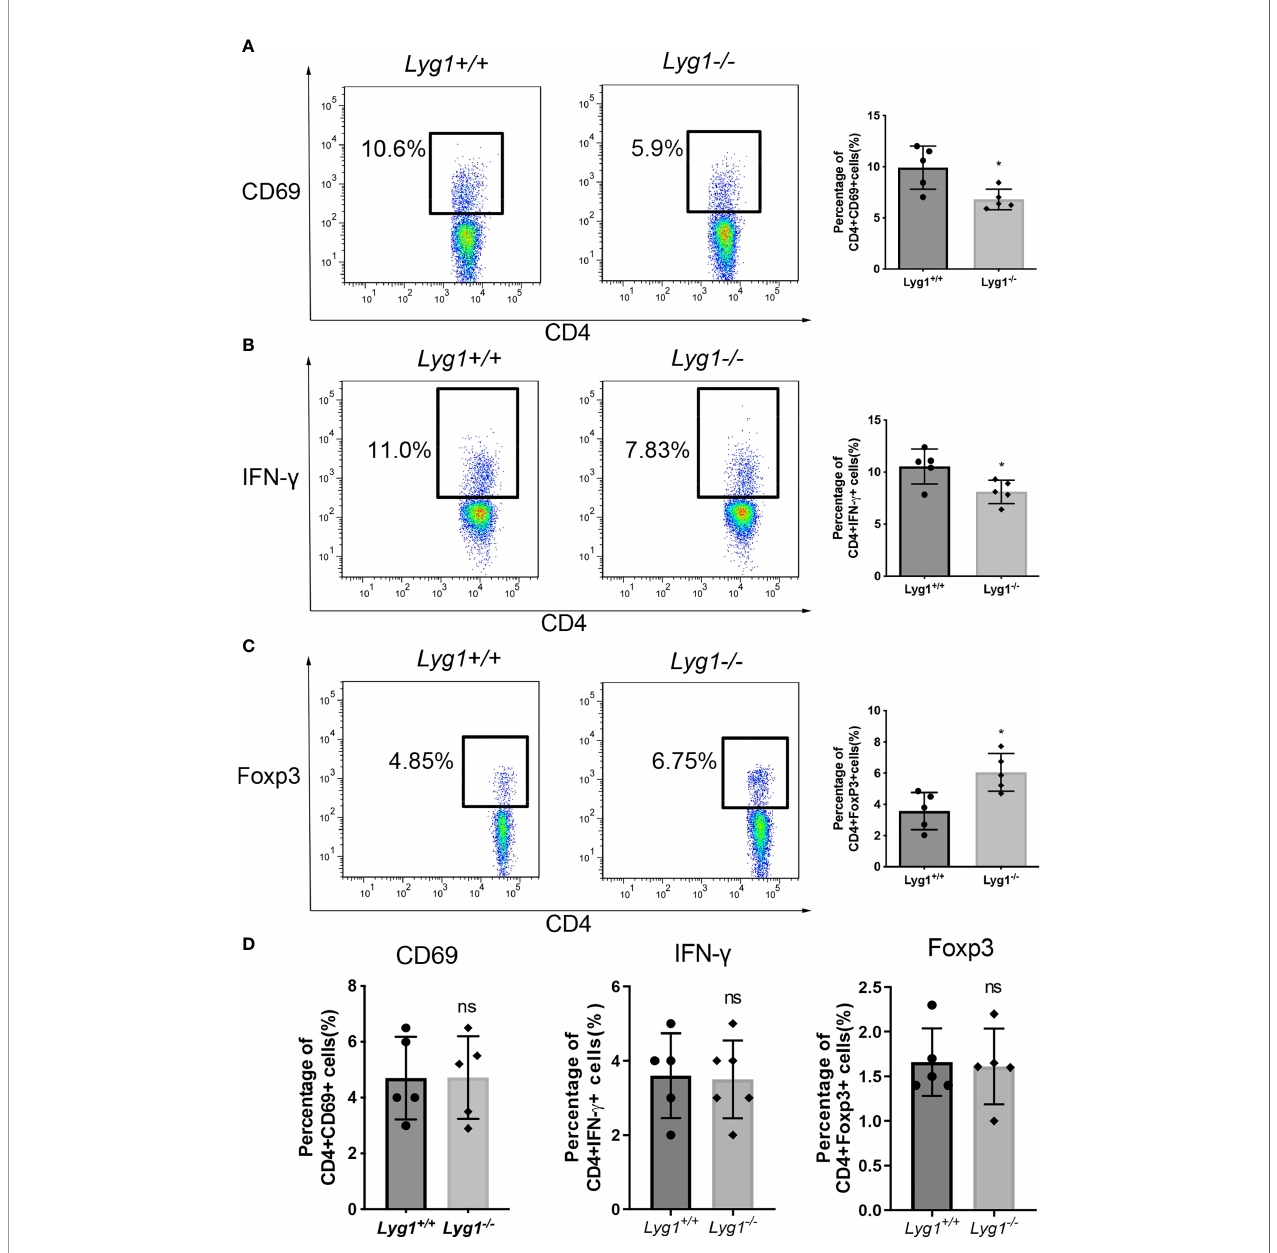
FIGURE 1 | LYG1 de fi ciency inhibited alloreactivity of CD4 + T cells in vitro . In MLR assay, CD3 + T cells from Lyg1 +/+ or Lyg1 -/- mice as responder cells were cultured with mitomycin treated splenocytes from BALB/c mice as stimulator cells. After 5 days, CD69 expression (A) , Th1 (B) and Treg (C) in the responder CD4 + T cells were detected by fl ow cytometry analysis. (D) The expression of CD69, IFN- g and Foxp3 gated on Lyg1 +/+ and Lyg1 -/- CD4 + T cells prior to the culture. Independent experiment was performed 3 times. n = 5 per group. Representative plots gated on H2Kb+CD4+ T cells are shown and statistical results are expressed as the mean ± SD, *p < 0.05 compared with Lyg1 +/+ group. ns, no signi fi